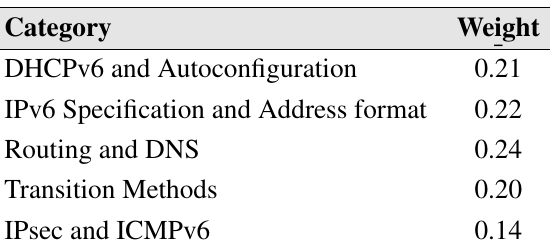
Table 4. Category weights (n =